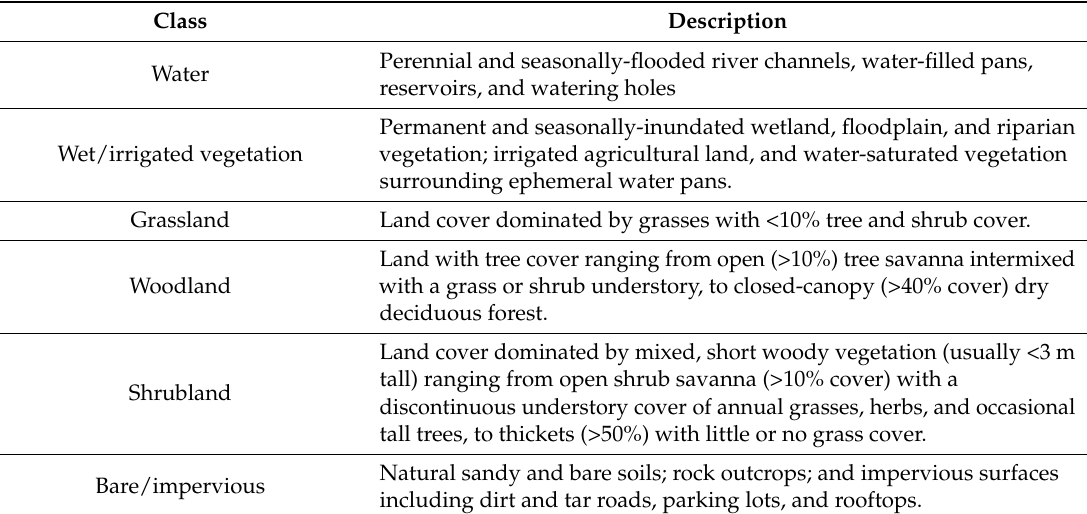
Table 1. Land-cover classifications based on 2010 FAO Forest Resources Assessment designations. Class Description Perennial and seasonally-flooded river channels, water-filled pans, Water reservoirs, and watering